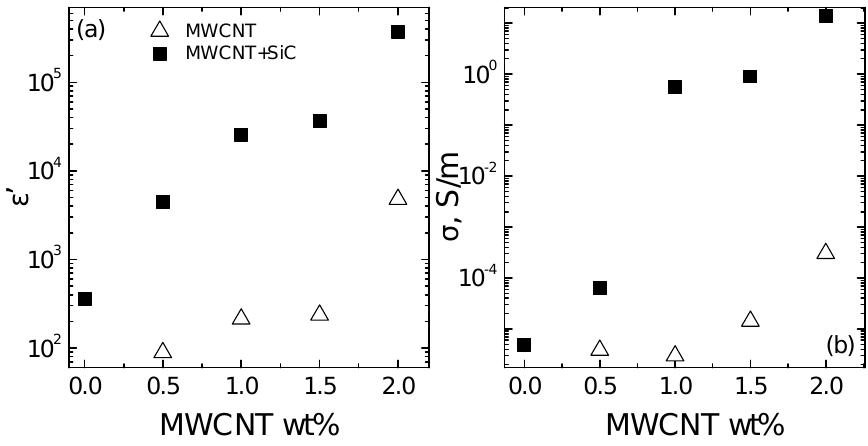
Figure 3. Dielectric permittivity ( a ) and ( b ) conductivity of the hybrid samples and MWCNT-filled samples as a function of MWCNT concentration at the fixed frequency of 129